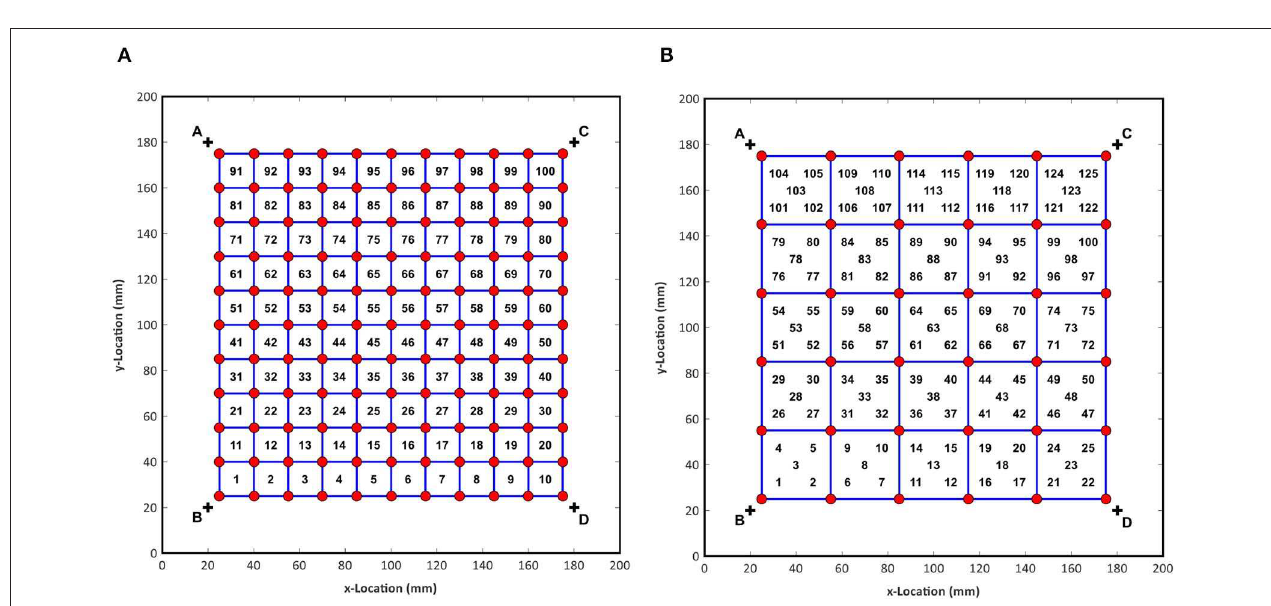
FIGURE 3 | CFRP plate baseline grid and sensor configuration for no refinement (A) and with refinement (B) .